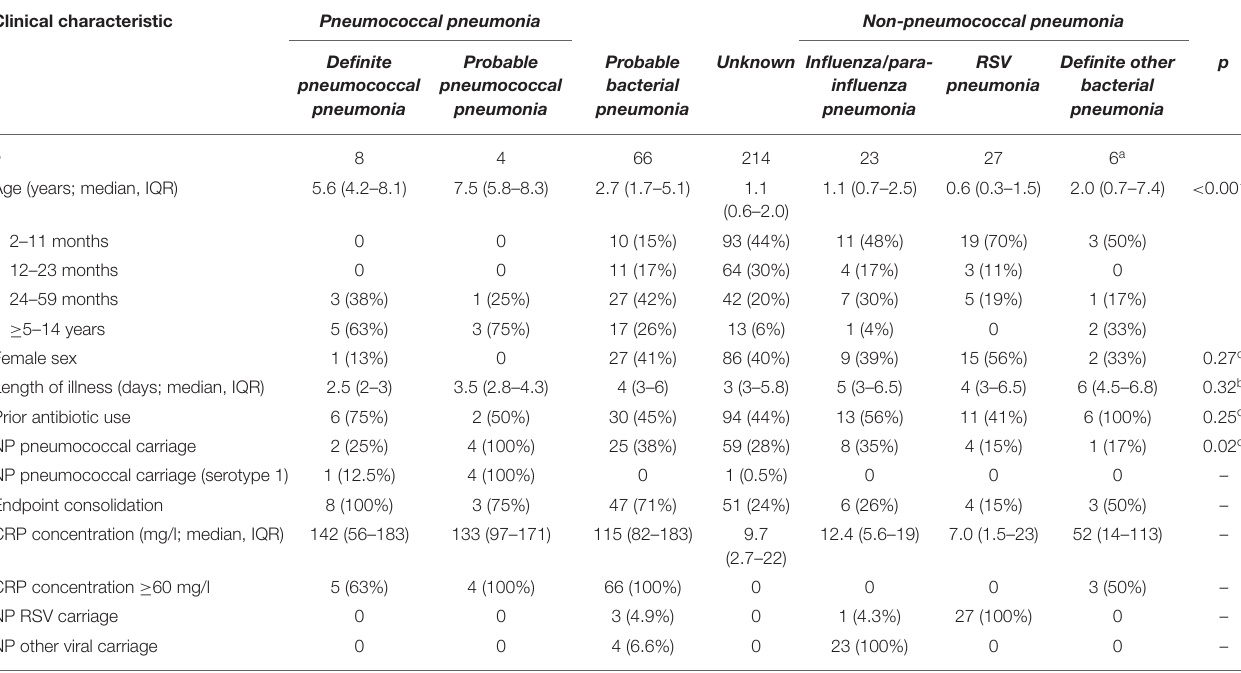
TABLE 1 | Clinical characteristics of children of all ages with pneumonia enrolled to the study, by comparator group. Clinical